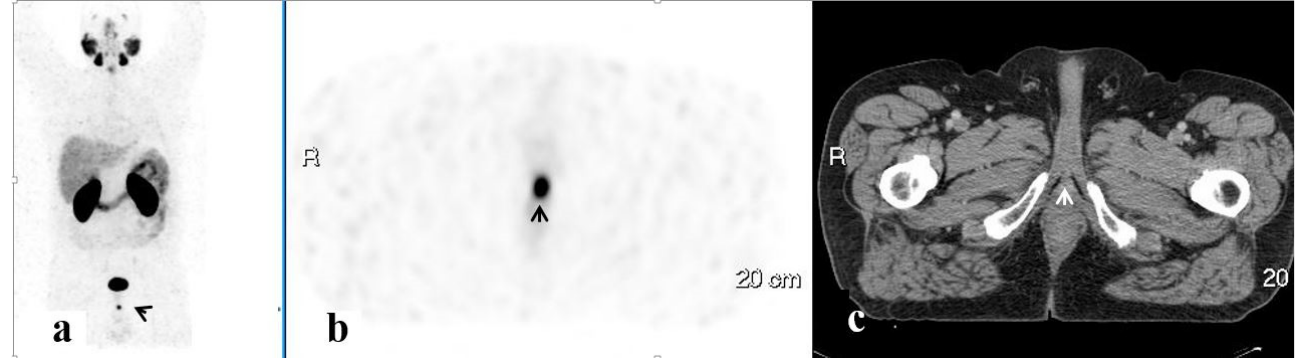
Figure 5. A PSMA-avid lesion in a blastic lesion in the iliac bone. 68Ga-PSMA scan, maximum intensity projection (MIP) ( a ) and corresponding PET ( b ) and CT ( c ) axial slices demonstrating focally increased uptake in the blastic lesion in the iliac bone on the left (arrows).